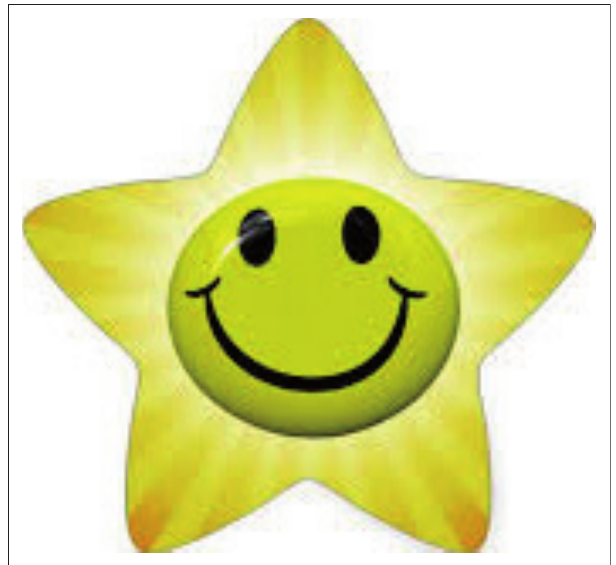
FIGURE 1: Symbol used for station